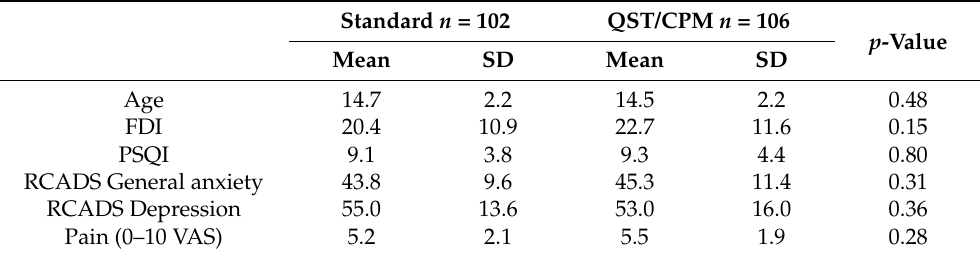
Table 2. Patients’ characteristics at baseline ( n =